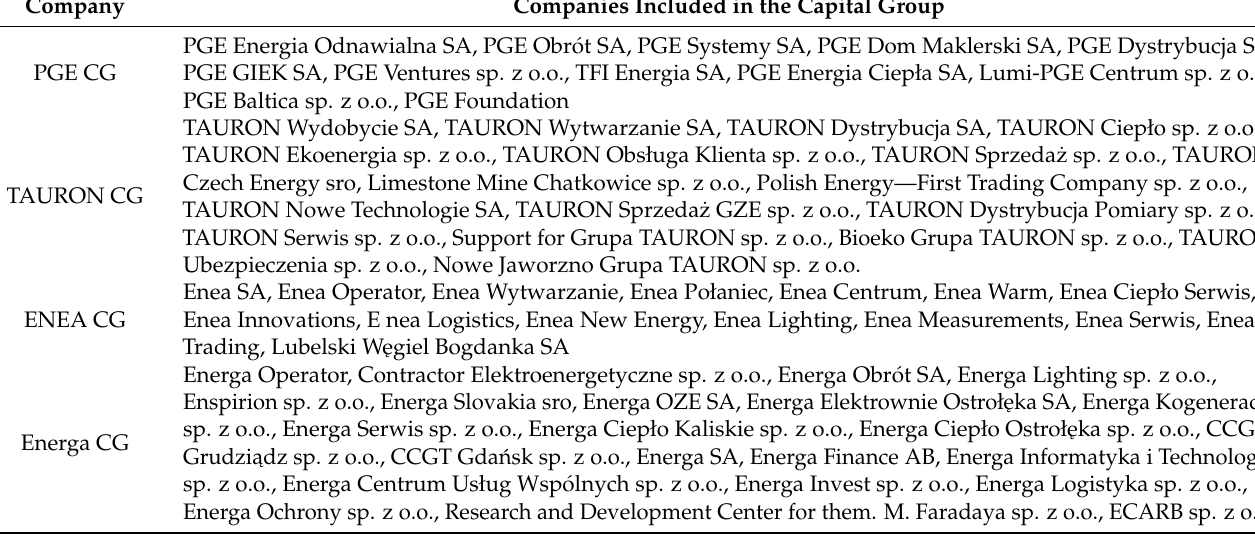
Table 8. Entity structure of leading capital